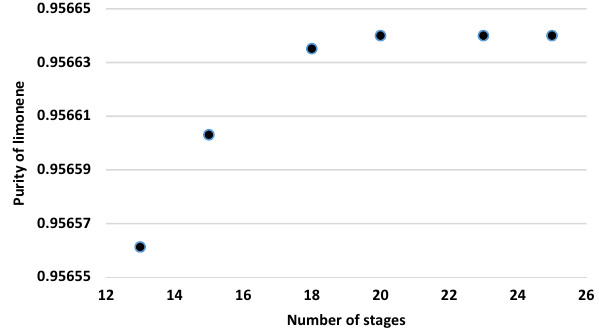
Figure 3. Effect of number of stages of first distillation column on limonene purity.